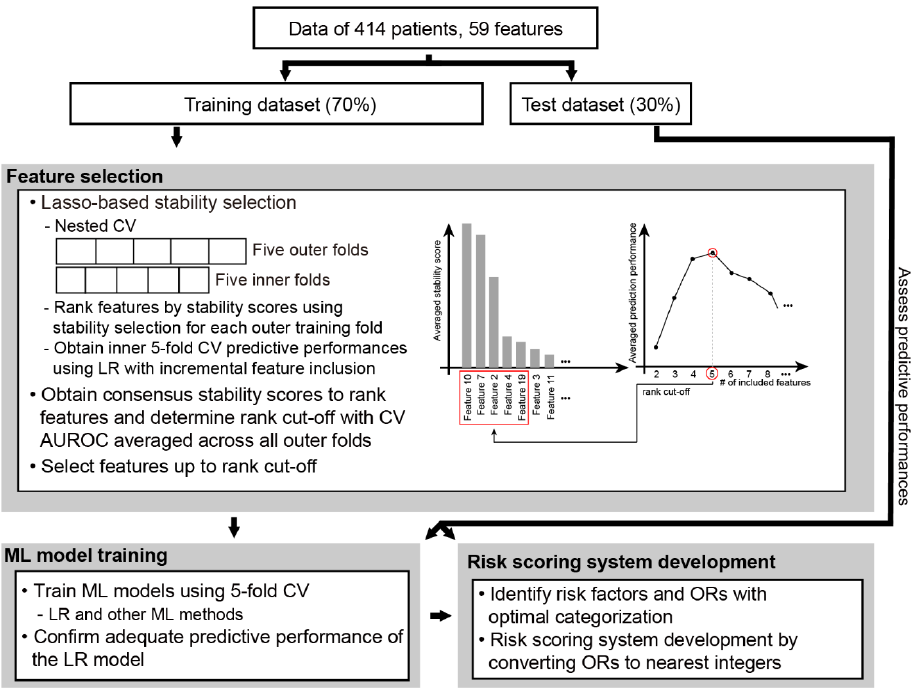
Figure 1. Overall workflow. CV, cross-validation; LR, logistic regression; OR, odds ratio.